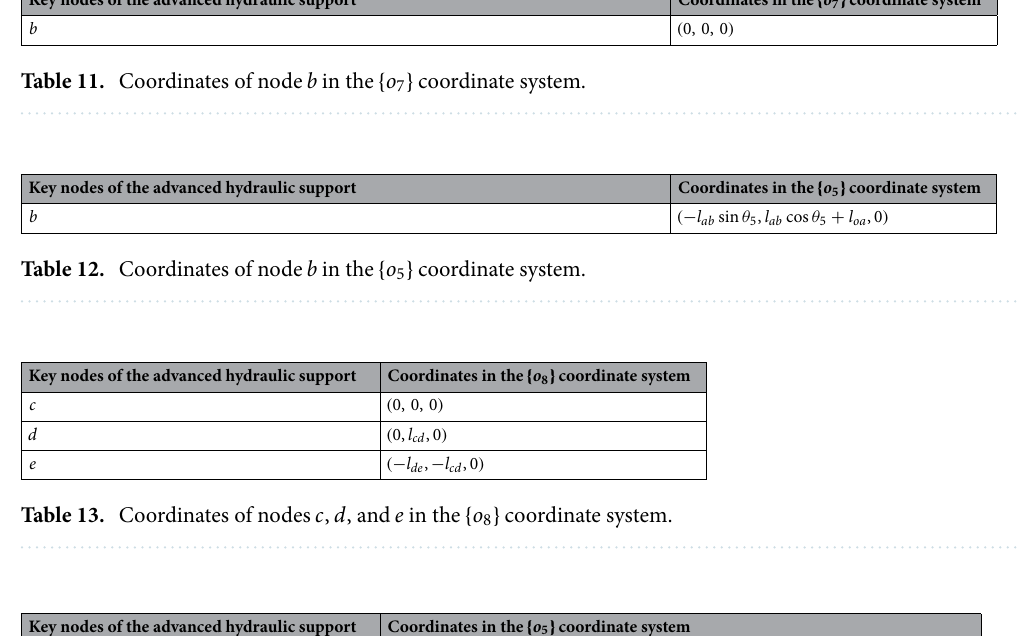
Key nodes of the advanced hydraulic support